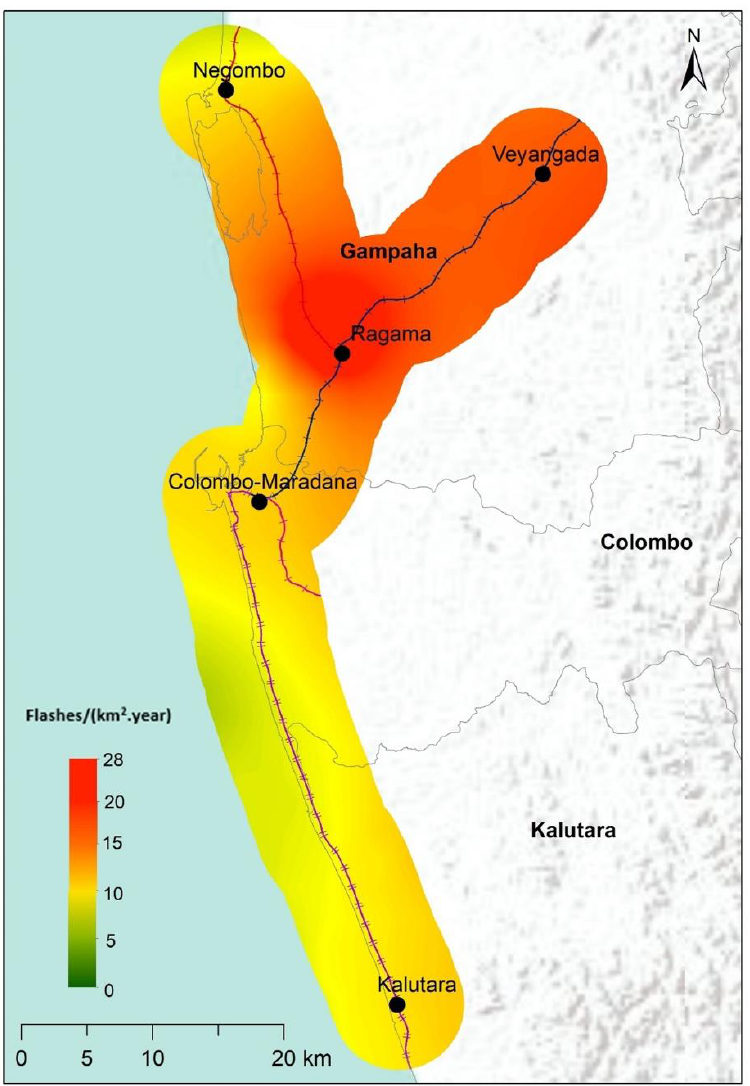
Figure 7. Spatial variability of the lightning flash density over the railway lines that are expected to be electrified. Table 5. Descriptive statistics of the variability of the annual lightning flash density (flashes/(km 2 ⋅ year)) over the expected electrified railway lines.